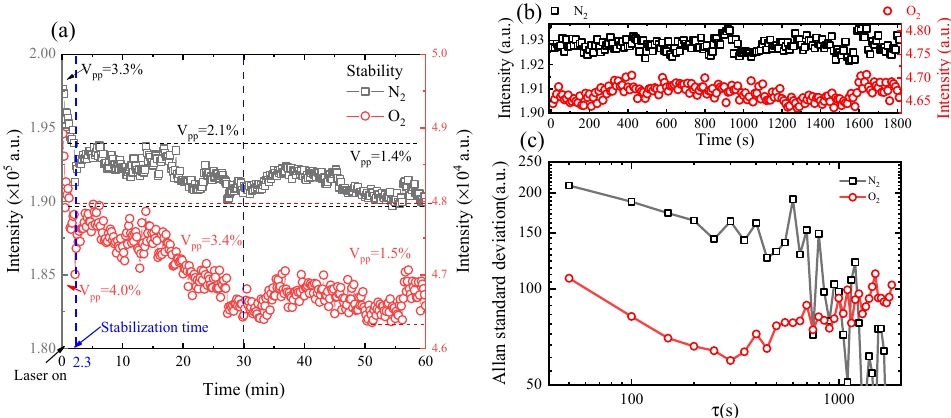
Figure 6. ( a ) The stability of this system over one hour of measurement; ( b ) the background correction data from 30 to 60 min; ( c ) the Allan standard deviation of N 2 and O 2 signals in the final 30 min.